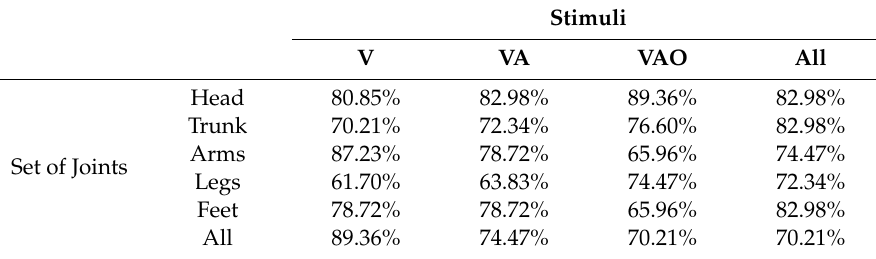
Table 1. Overview of the accuracy of each model considering the stimuli and set of joints.